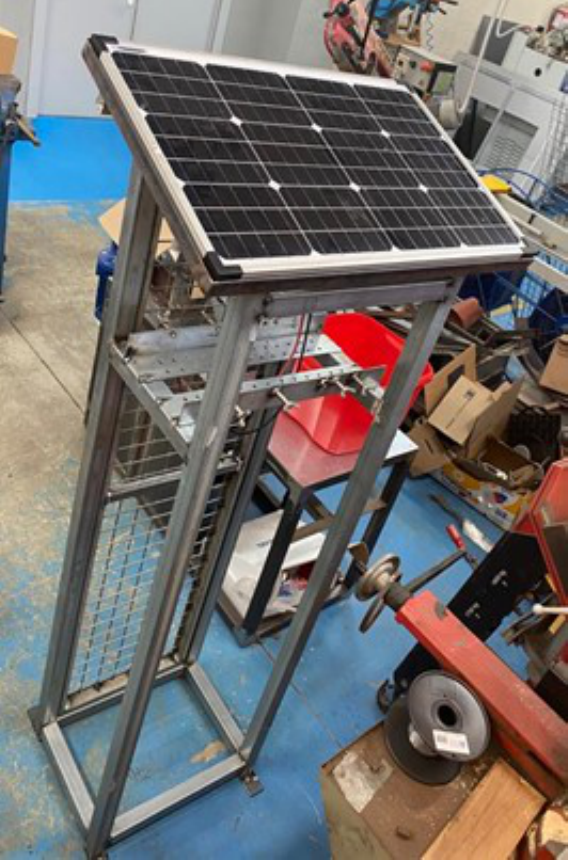
Figure 8. Storage structure for the air quality monitoring sensors in its development